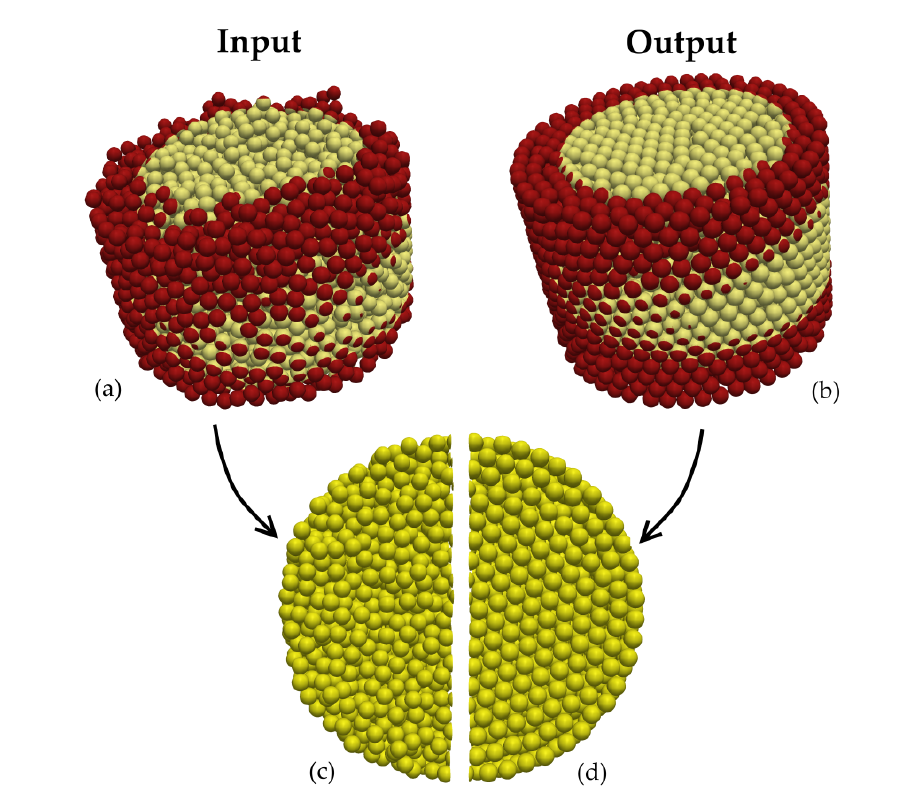
Figure 3. Algorithm input and output example (bi-color applied for visualization enhancement). ( a ) random loose packing input; ( b ) close random packing output; ( c ) mid-height cross-section of very loose packing; ( d ) mid-height cross-section of close random